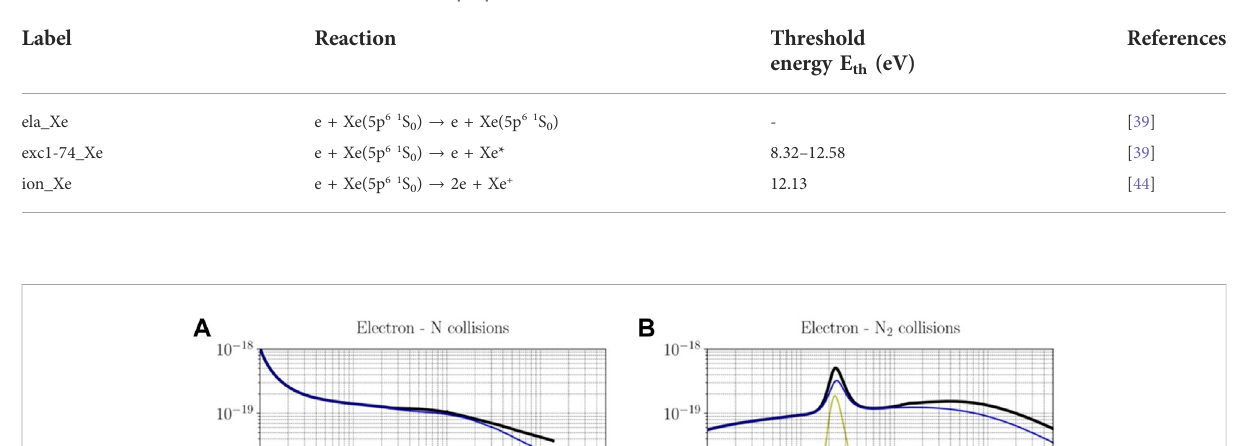
TABLE 4 Reactions between electrons and Xe in the proposed PIC-TPMC model.